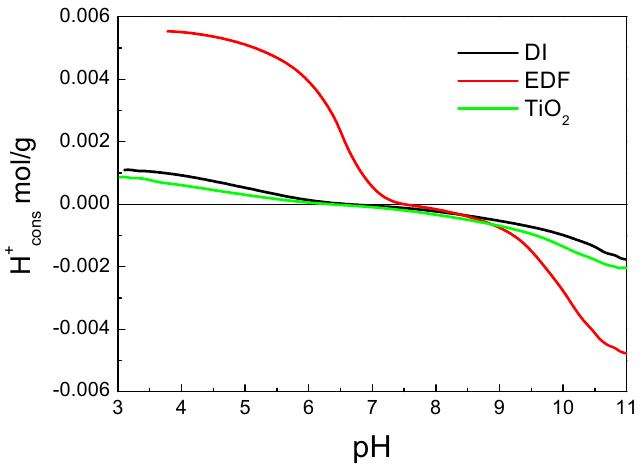
Figure 9. H + consumption curves for the three samples as a function of pH suspension.